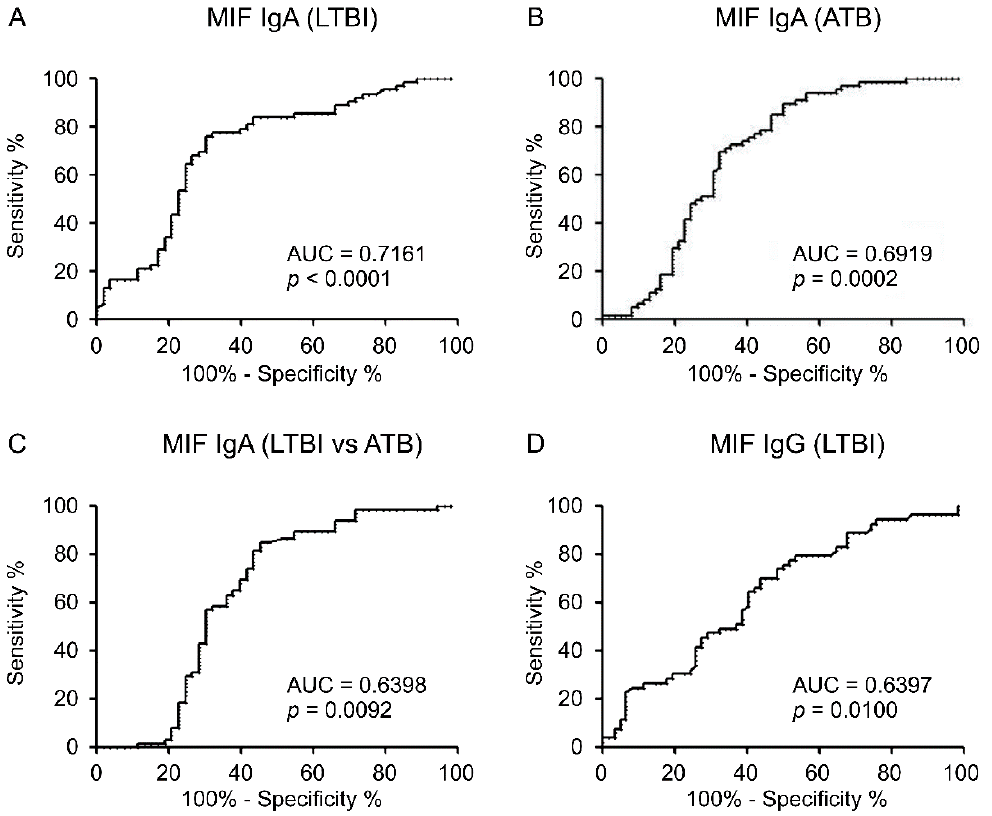
Figure 2. Receiver operating characteristic (ROC) curves were used to evaluate whether anti- macrophage migration inhibitory factor (MIF) immunoglobulin (Ig)A can distinguish between non-infected (NI) and latent tuberculosis infection (LTBI) ( A ), whether anti-MIF IgA can di ff erentiate between NI and active tuberculosis (ATB) ( B ), whether anti-MIF IgA can distinguish LTBI and ATB ( C ), and whether anti-MIF IgG can di ff erentiate between NI and LTBI ( D ). Each area under the curve (AUC) and p value are indicated on the graphs. Table 1. E ffi ciencies of immunoglobulin (Ig)A and IgG against MIF as diagnostic markers for